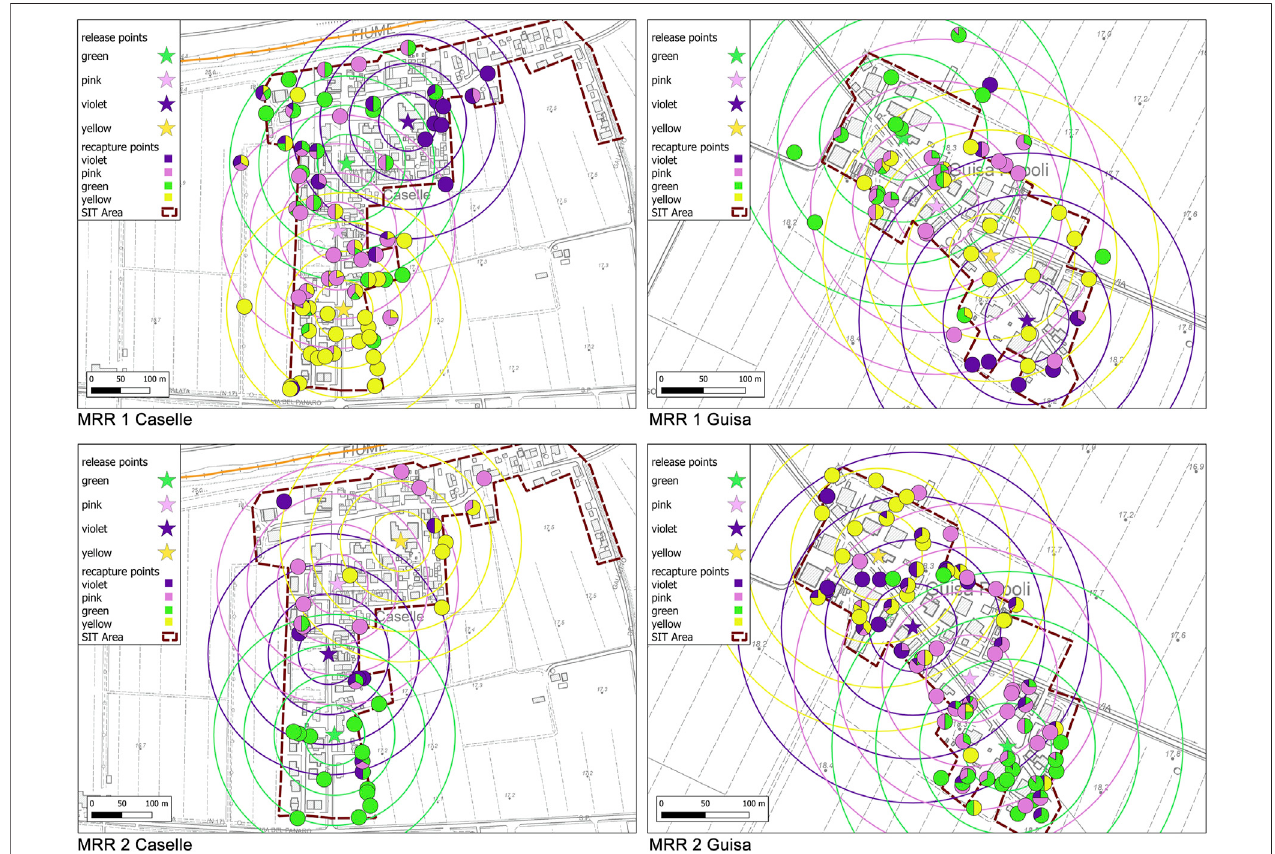
FIGURE 2 | Maps of the recapture points (HLC – circles) located into concentric annuli of 50 m up to the maximum of 200 m radius around the release stations (stars) de fi ned during the different MRR trials in Caselle and Guisa Pepoli. The HLC circles are colored according to the percentage of recapture of males of different colors collected in each